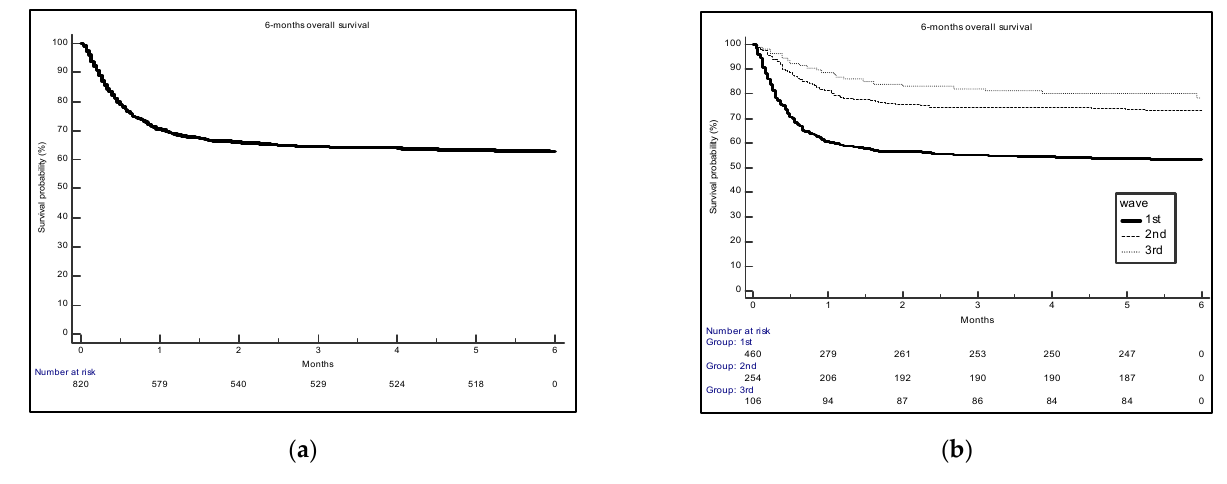
Figure 1. Survival probability overall ( a ) and by each of the first three pandemic waves ( b ). Table 3 reports the results of the univariable and the multivariable analysis on the effect of selected characteristics in relation to the risk of death. Patients admitted during the second and the third wave had a lower risk of death within six months from the date of hospitalization in comparison with those admitted during the first (adjusted HR = 0.65; 95%CI 0.48–0.88, and adjusted HR = 0.44; 95%CI 0.28–0.70, respectively). The multivariable analysis also showed that age (adjusted HR = 3.40; 95%CI 2.20–5.24), CCI (adjusted HR = 1.21; 95%CI 1.15–1.27), disease severity (adjusted HR = 1.87, 95%CI 1.43–2.45), and the need for oxygen therapy (adjusted HR = 2.30; 95%CI 1.61–3.30) were associated with an increased risk of death (Table 3). Table 3. Cox regression models for the risk of death at 6 months.